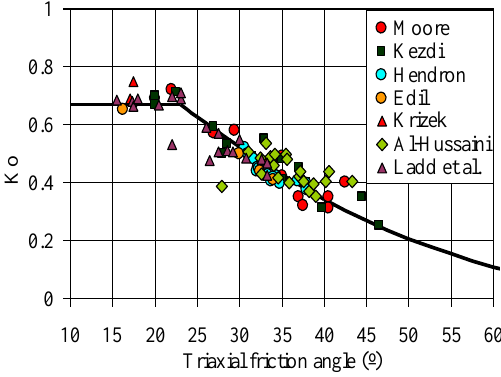
Fig. 4. Relationship between the friction angle and the coefficient of lateral pressure at rest, regarding the correction of the biaxial friction angle. Data compiled by